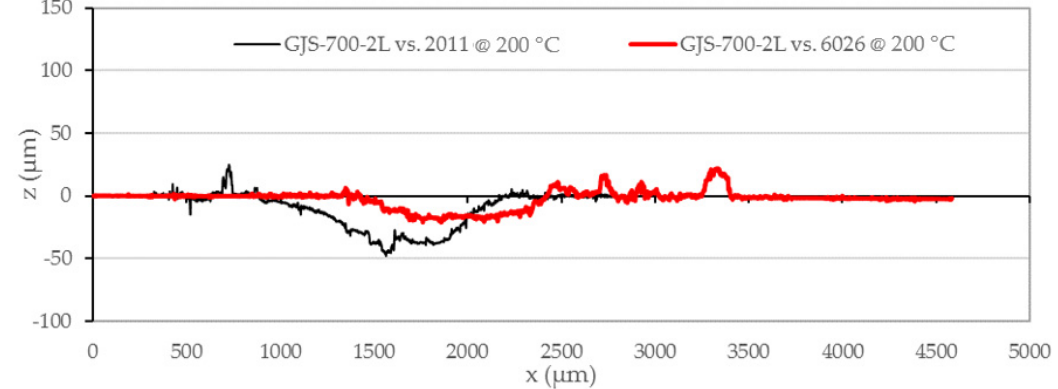
Figure 9. Depth profile of the track. Comparison between GJS-700-L2 disk profiles for tests against 2011 and 6026 at 200 °C.